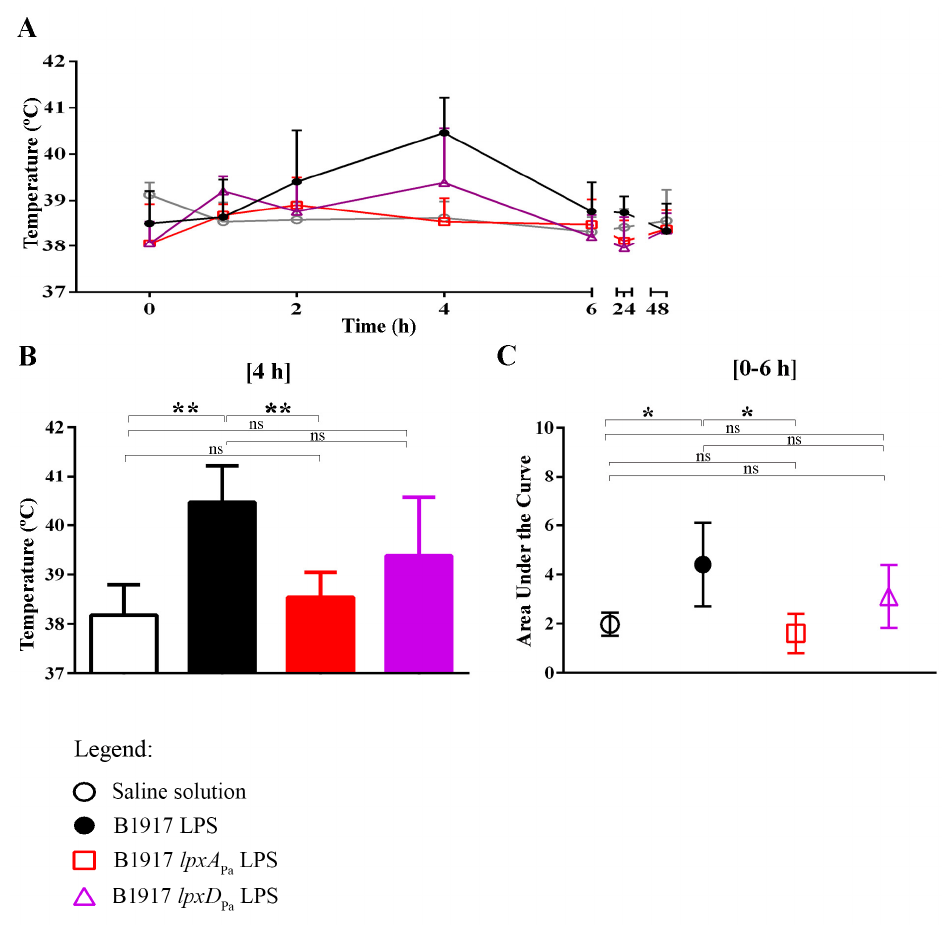
Figure 4. Pyrogenicity assays in rabbits. Groups of five animals were injected with saline solution (control) or with 10 μg of B. pertussis B1917 wild-type LPS, or mutant LPS derivatives resulting from the expression of lpxA Pa or lpxD Pa . The temperature of each animal was monitored at different time intervals after injection. ( A ) Mean body temperature and standard deviation for each group before injection (0 h) and at different times post-injection are shown (1, 2, 4, 6, 24, 48 h). ( B ) The differences in body temperatures within groups at 4 h post-injection. Statistically significant differences were determined using ANOVA and Dunnett tests and are indicated with two asterisks ( p < 0.001). ns, not significant. (C) The mean of area under the curve and standard deviation of all animals of a group were calculated between 0 and 6 h using as baseline the mean of each group. Statistically significant differences between the two groups are indicated with one asterisk ( p < 0.05) using an unpaired t-test. Ns, not significant.